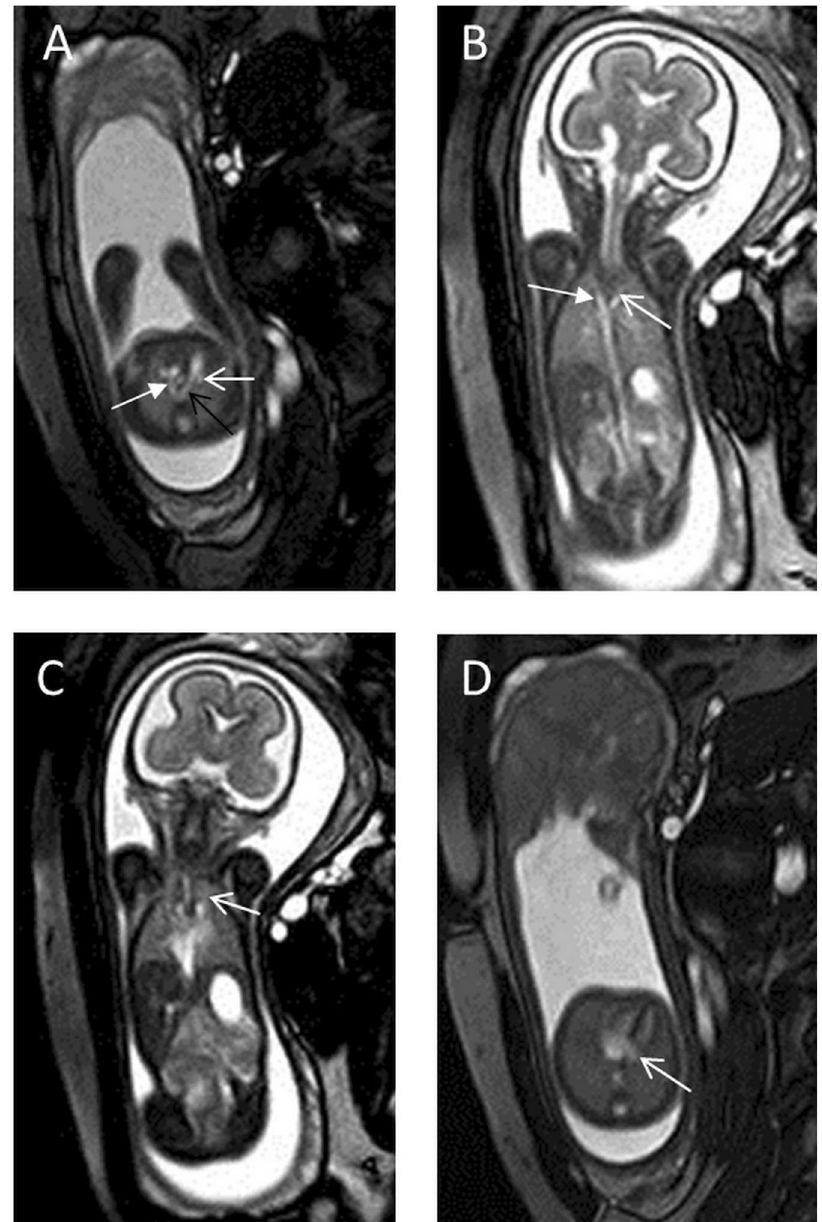
Figure 4. A 22-week fetus with right aortic arch with an aberrant left subclavian artery and persistent LSVC. Fetal CMR B-TFE transverse view of the aortic arch and coronal views show persistent LSVC (white open arrows in A and C ) and the right aortic arch (arrows in A and B ) with an aberrant left subclavian artery (black open arrow in A and white open arrow in B ); four-chamber view shows an enlarged coronary sinus (open arrow in D